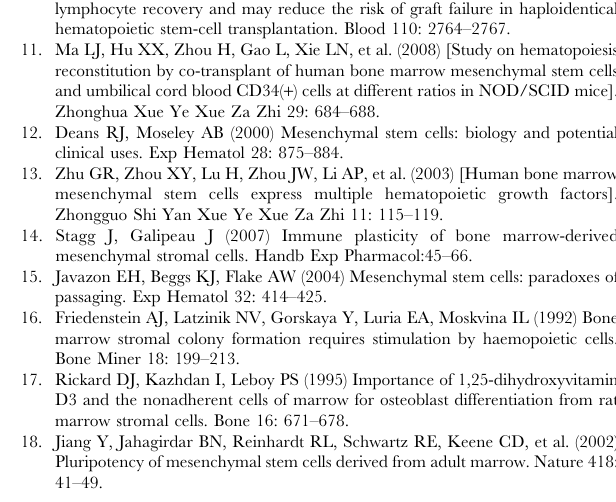
Figure S2 Complete comparative flow cytometric analysis of bone marrow and NA-BMCs from Balb/c and C57Bl/6. Cells were gated for CD45 expression and co-expression of CD4, CD8, CD19, CD117, CD117 + /CD90 low , CD31, CD11b, MHC-II, CD90 for bone marrow cells and NA-BMCs derived from Balb/c and